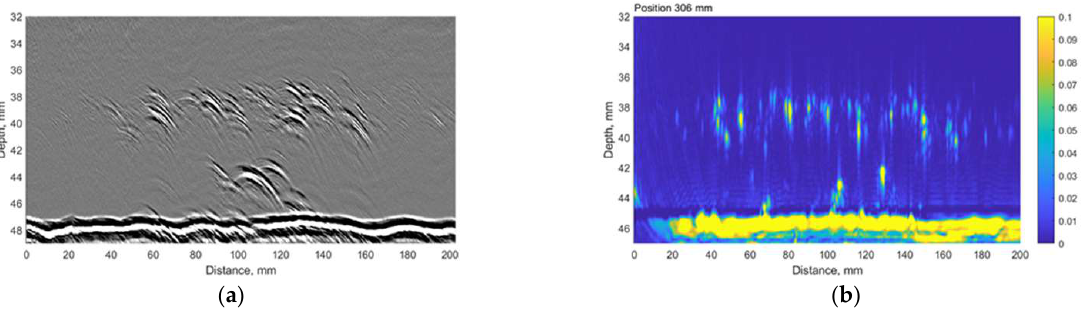
Figure 16. The comparison between ( a ) TULA and ( b ) TFM measurements at 306 mm circumferential scan position. Vertical colour bar represents the peak-to-peak amplitude in arbitrary units.